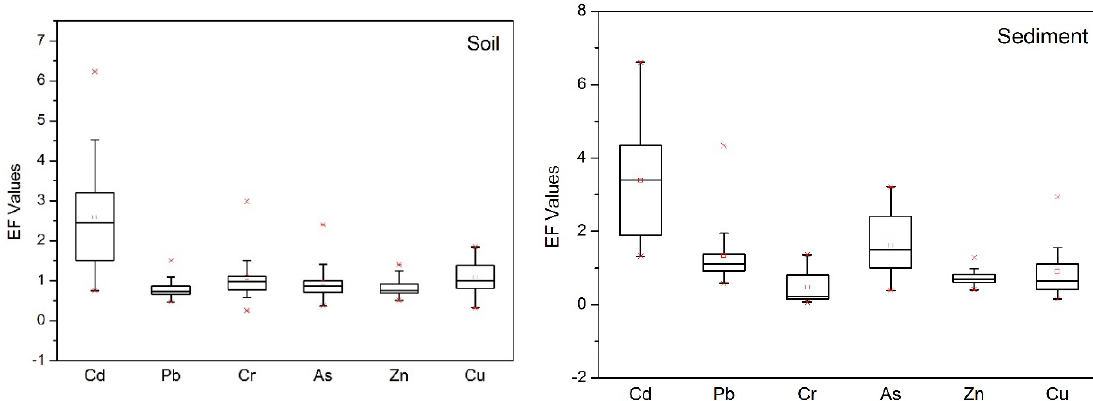
Figure 2. The EF values of potentially toxic elements in soil and sediment (The upper × indicates 95th percentile and the lower × indicates 5th percentile value, respectively □ indicate median value).